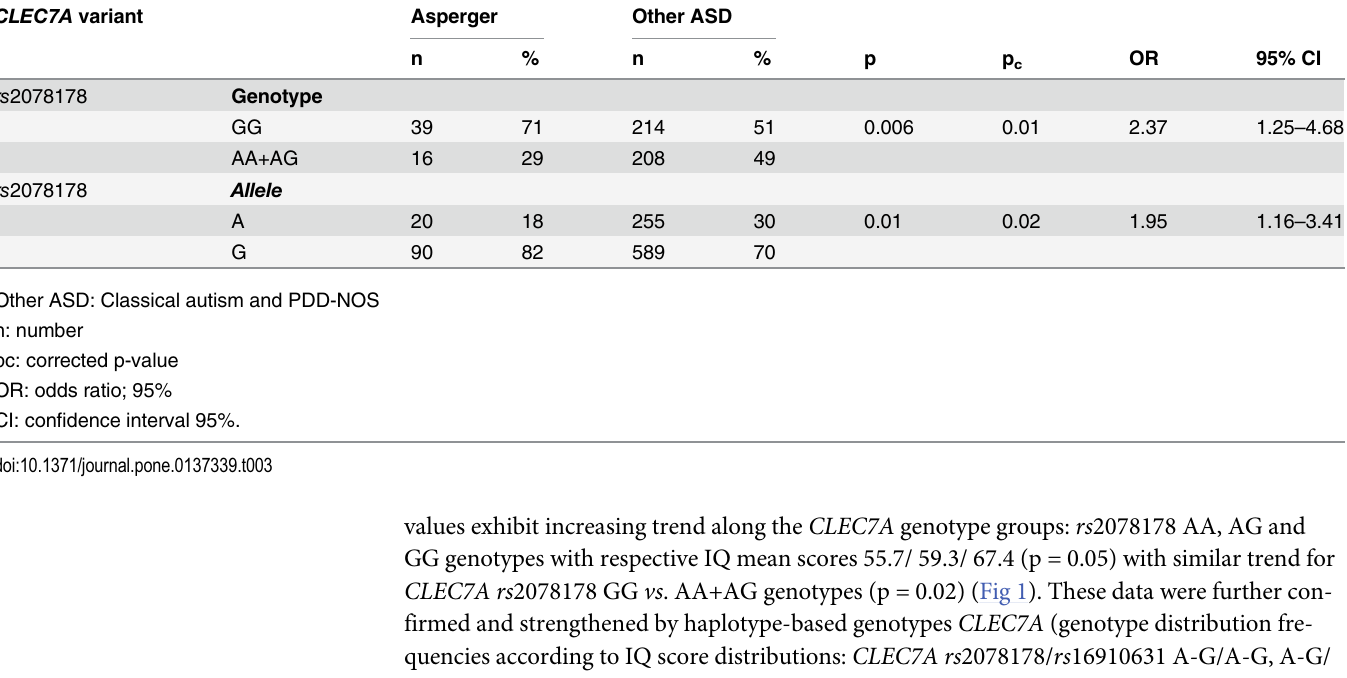
Table 3. CLEC7A alleles and genotypes distribution in patients with Asperger and other ASD types. CLEC7A variant